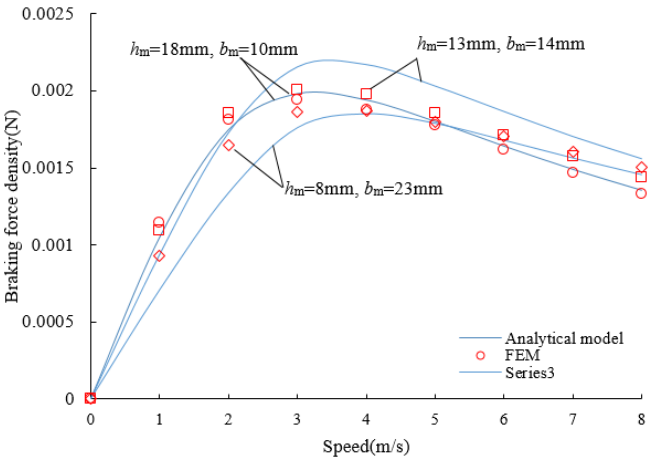
Figure 12. Braking force density-speed characteristic for different magnet